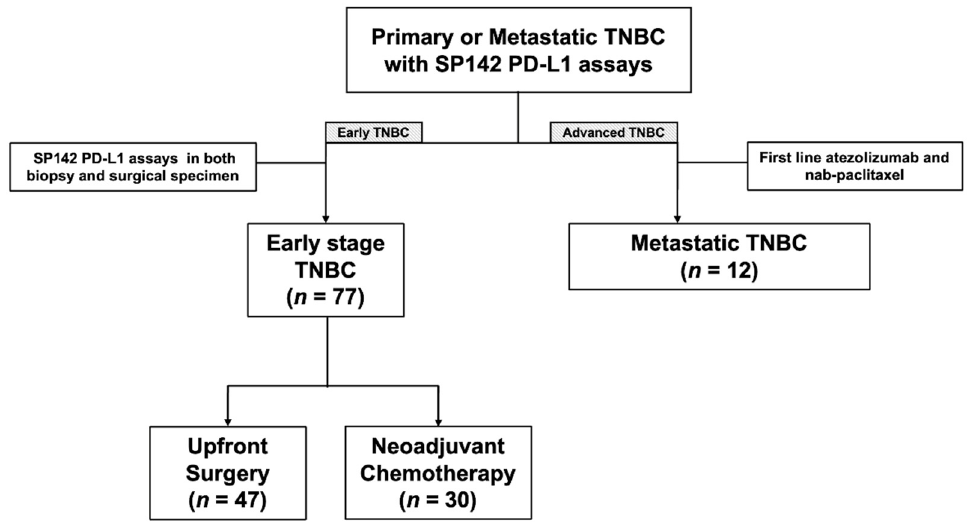
Figure 1. Diagram of the study